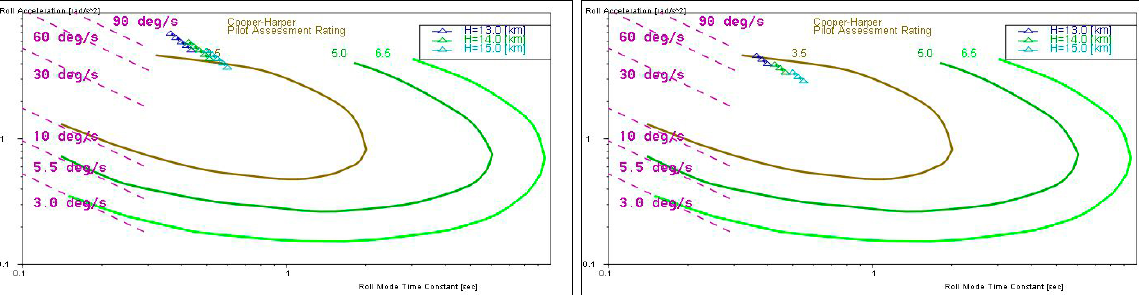
Fig. 18. The Cooper-Harper pilot assessment for configuration No. 1 (on the left) and configuration No. 2 (on the